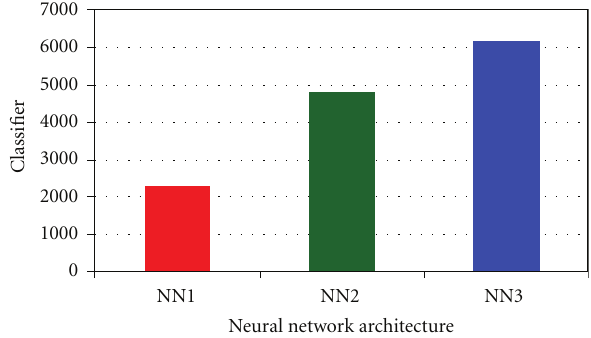
Figure 10: Comparison between three optimal neural networks using one hidden layer denoted NN1 ( n 1 = 7 neurons), two hidden layers denoted NN2 ( n 1 = 1 and n 2 = 5) and three hidden layers denoted NN3 ( n 1 = 2 and n 2 = 7 and n 3 = 10) showing the neural network with three hidden layers to have the best performance with the highest classifier ( − ρ ).